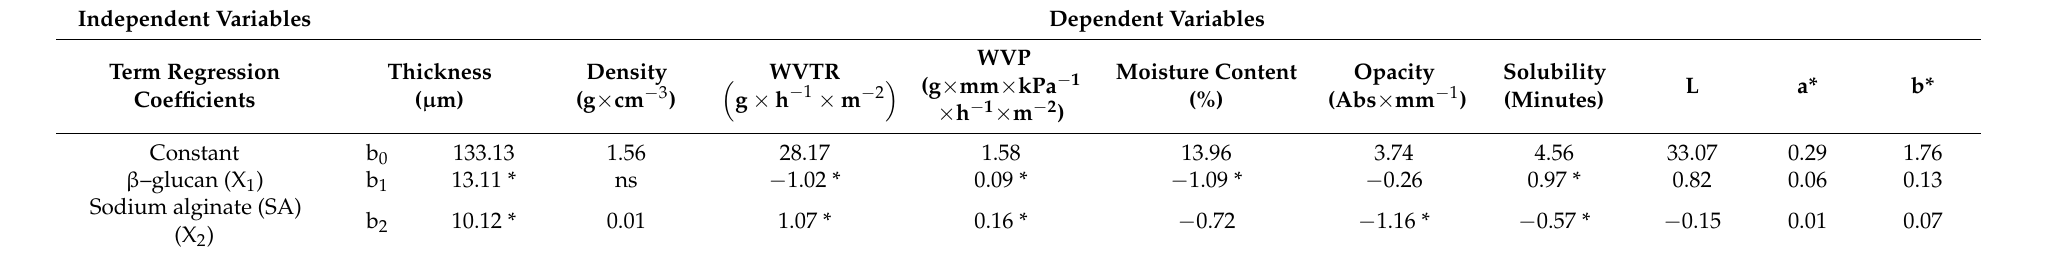
Table 5. Regression coefficients estimated of the quadratic model and their